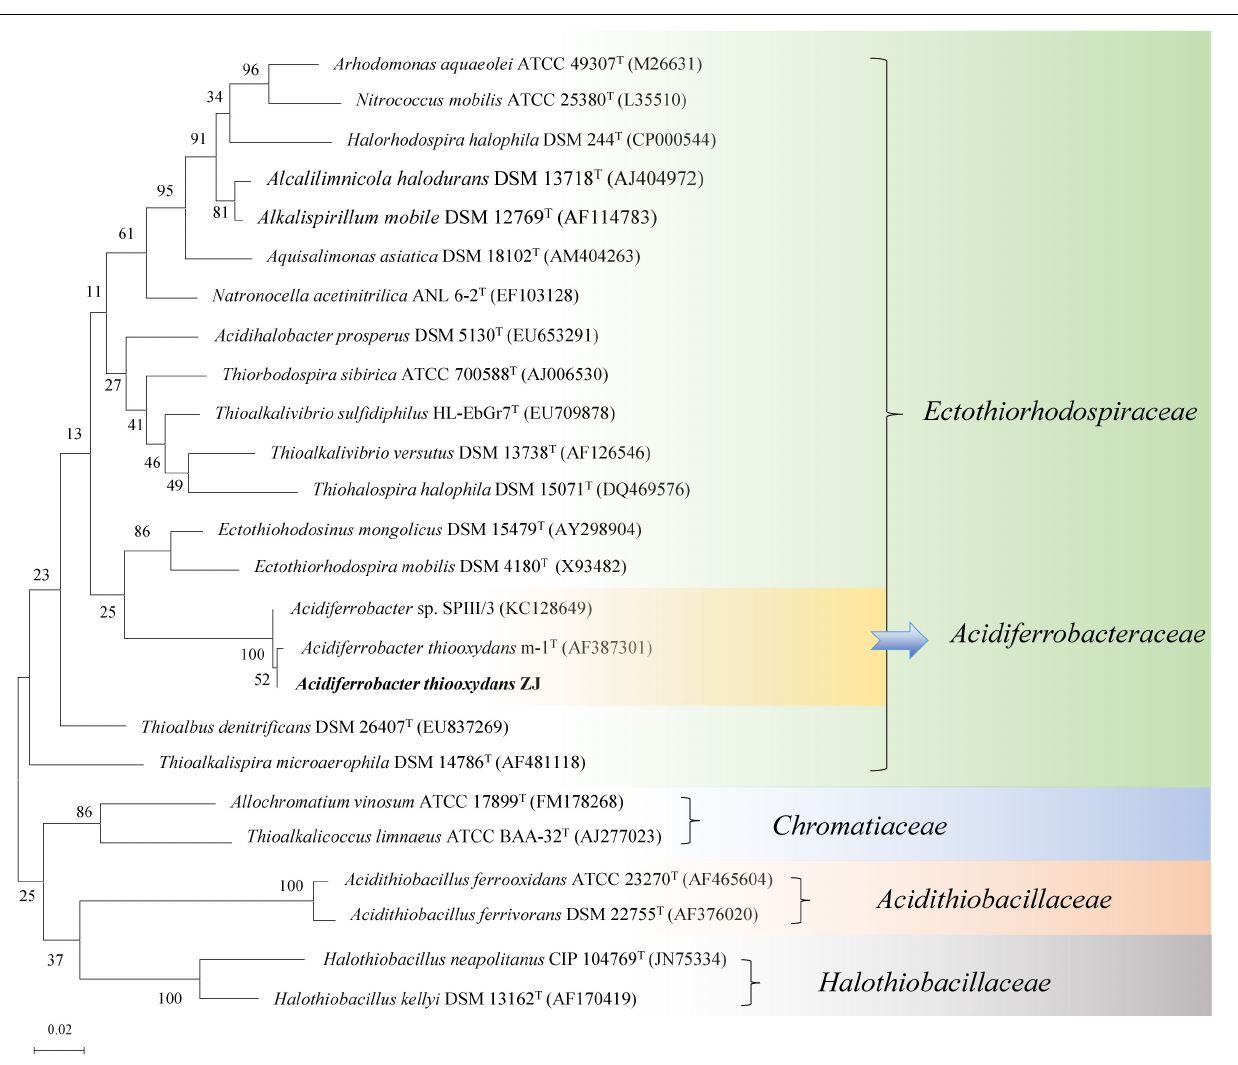
FIGURE 3 | Phylogenetic tree of Af. thiooxydans ZJ with the neighboring standard species based on 16S rRNA sequences. The tree was constructed by maximum likelihood method with bootstrap values calculated from 1,000 trees. The numbers at each clustering node indicate the percentage of bootstrap supporting. The scale bar 0.02 indicates evolutionary